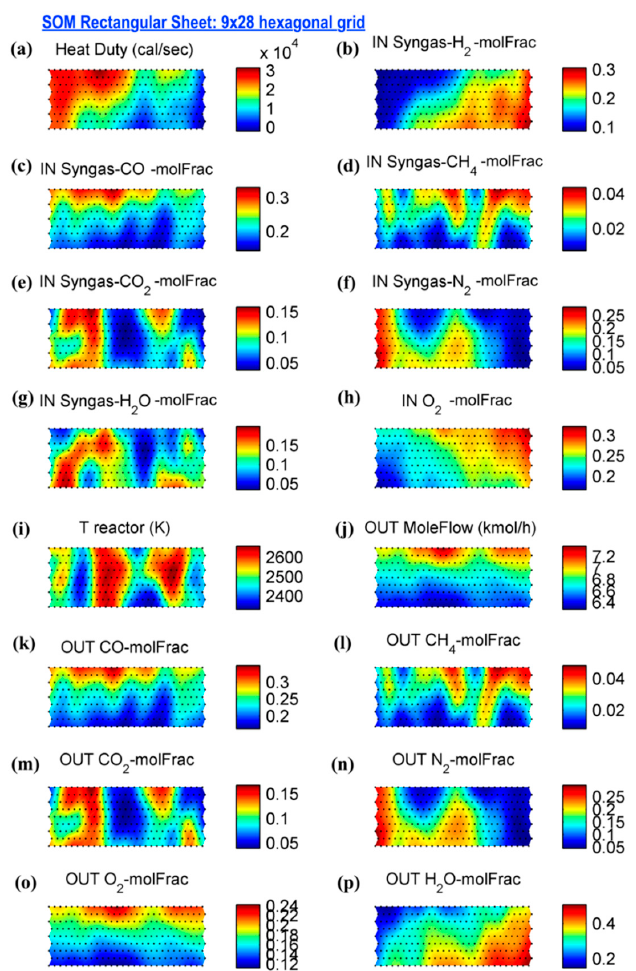
Figure 8. Surface projection of the system variables modelled through rectangular SOM consists of neurons in hexagonal pattern of nine grid rows × 28 grid columns. ( a ) process heat duty (cal/sec); ( b )– ( h ) mole fraction of chemical species in the feed; ( i ) reactor temperature; ( j ) total molar out flow from reactor; ( k )–( p ) mole fraction of chemical species in the reactor outflow stream.